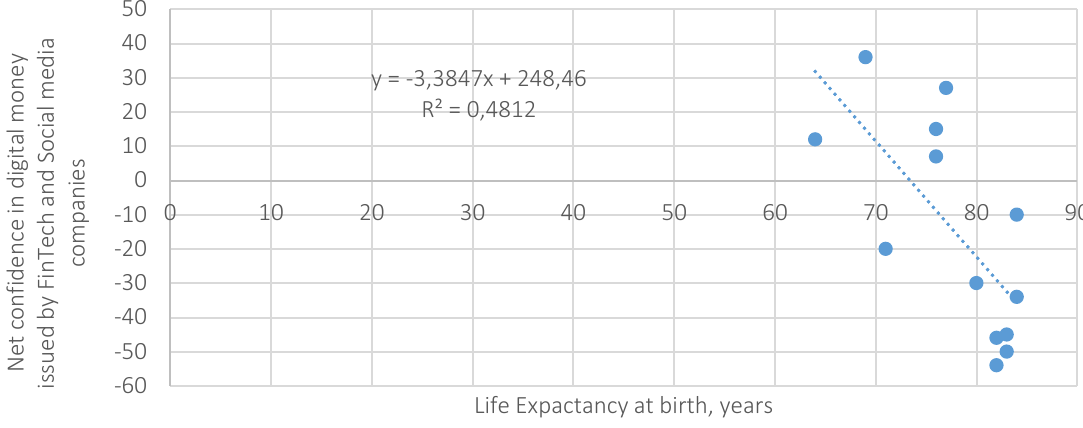
Figure Е5. Confidence in privately issued digital money and life expectancy